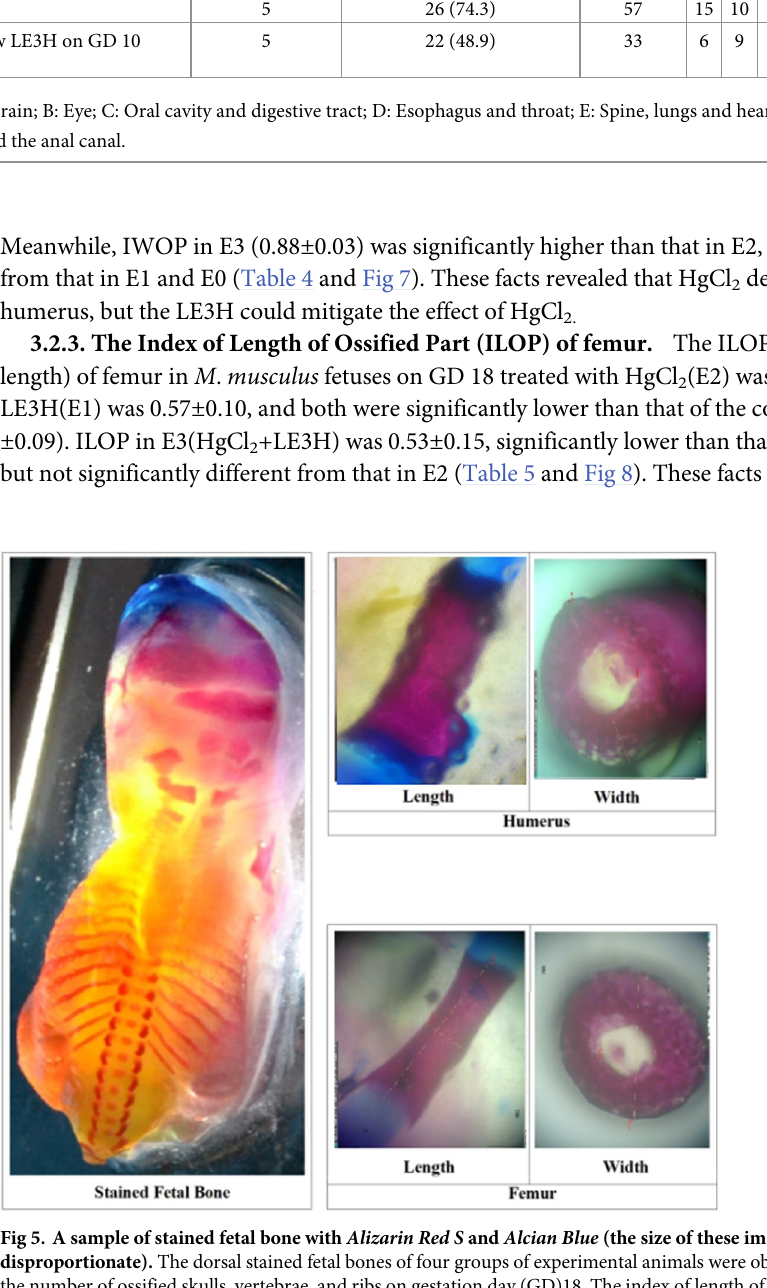
Table 2. Results of soft tissue examination using the free hand razor blade technique through eight points of fetus body on Gestation Day (GD) which previously were given 0.39 mg/g bw LE3H through gavage on GD10 (E1), injected with 5 mg/kg bw HgCl 2 on GD9 (E2), and administered 5 mg/kg bw HgCl 2 on GD9 and then 0.39 mg/kg bw LE3H on GD10 (E3). Meanwhile the controls (E0) were administered double-distilled water only. Group of Experimental Animals (GEA) Number of Dam Anatomical Defect (AD; E0: Controls were administered double-distilled water only.